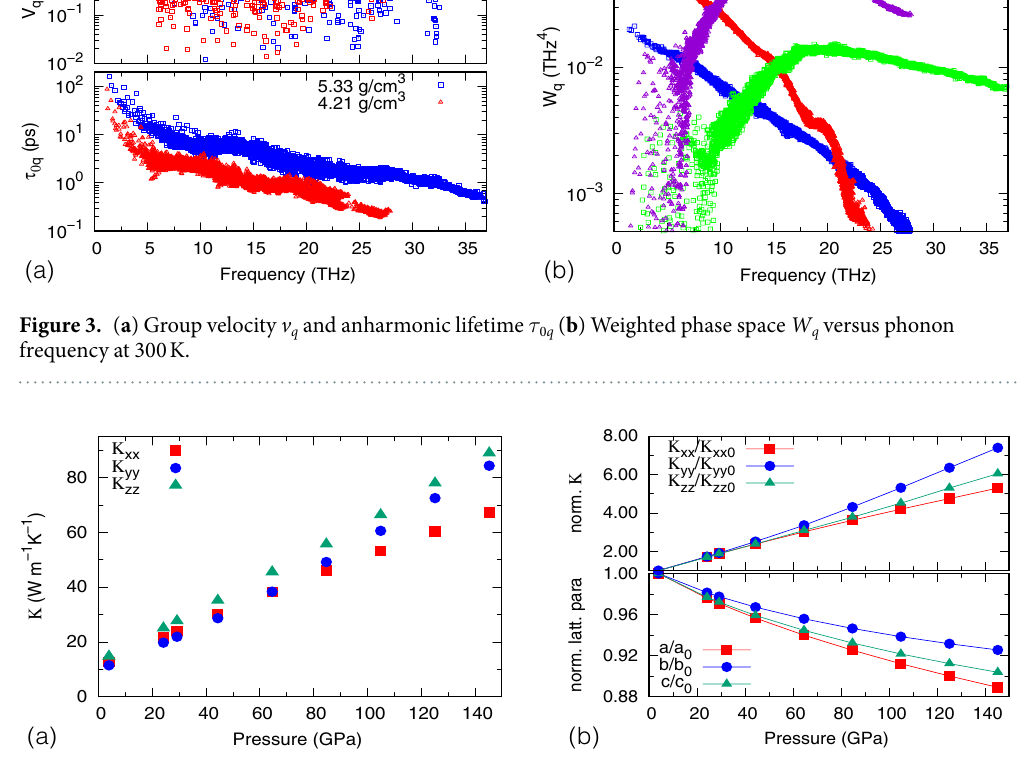
Figure 4. ( a ) Three diagonal components of κ as functions of pressure at 300 K; ( b ) Normalized conductivity κ κ αα / αα 0 and lattice parameters as functions of pressure at 300